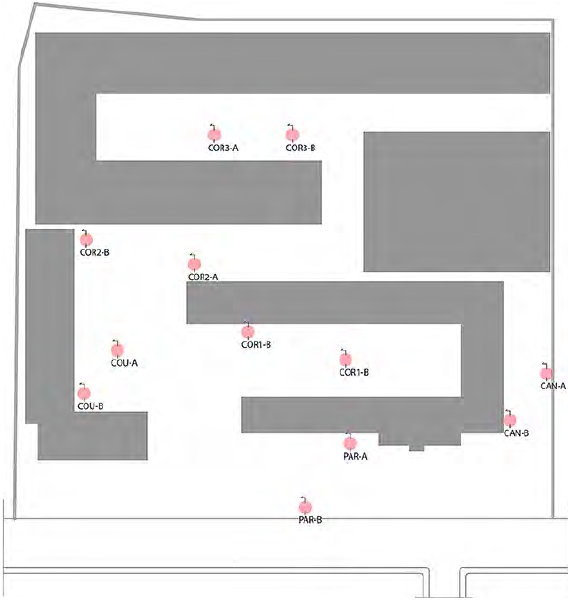
Figure 11. Twelve points location in case study (six